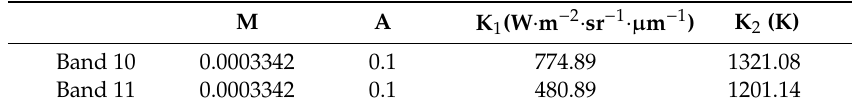
Table 1. Constants for computing brightness temperature from Landsat 8 Thermal Infrared Sensor (TIR)